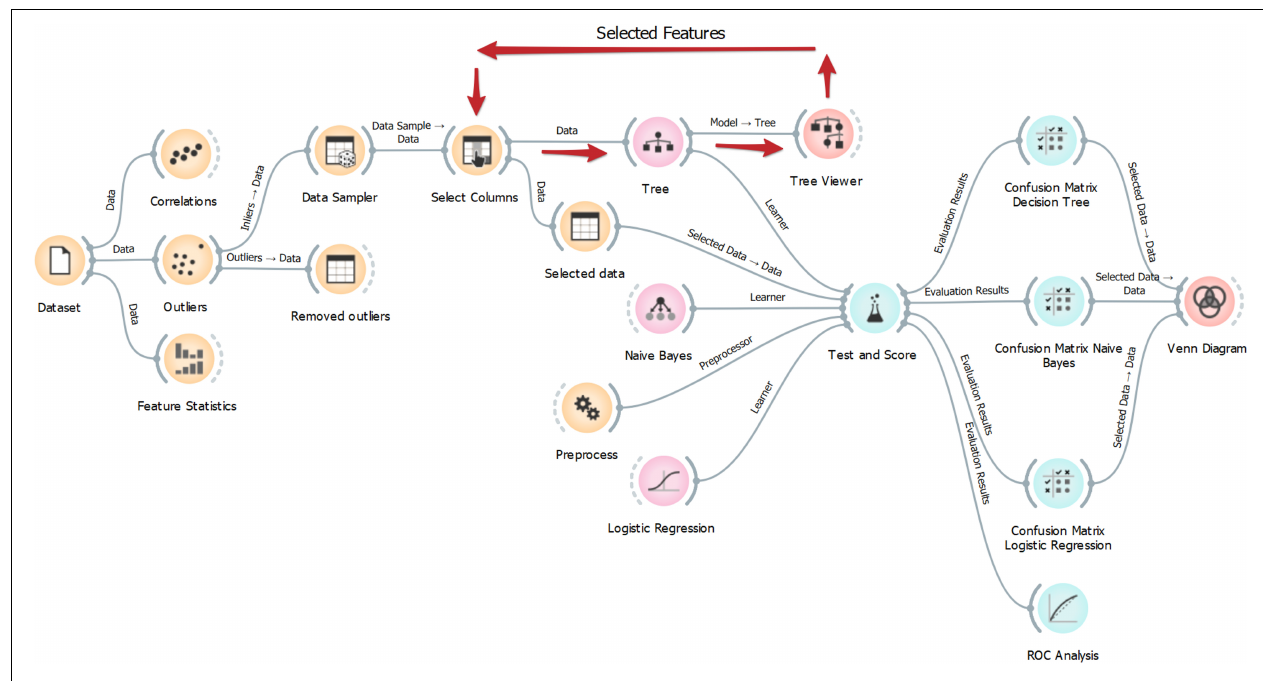
FIGURE 1 | Orange workflow for data